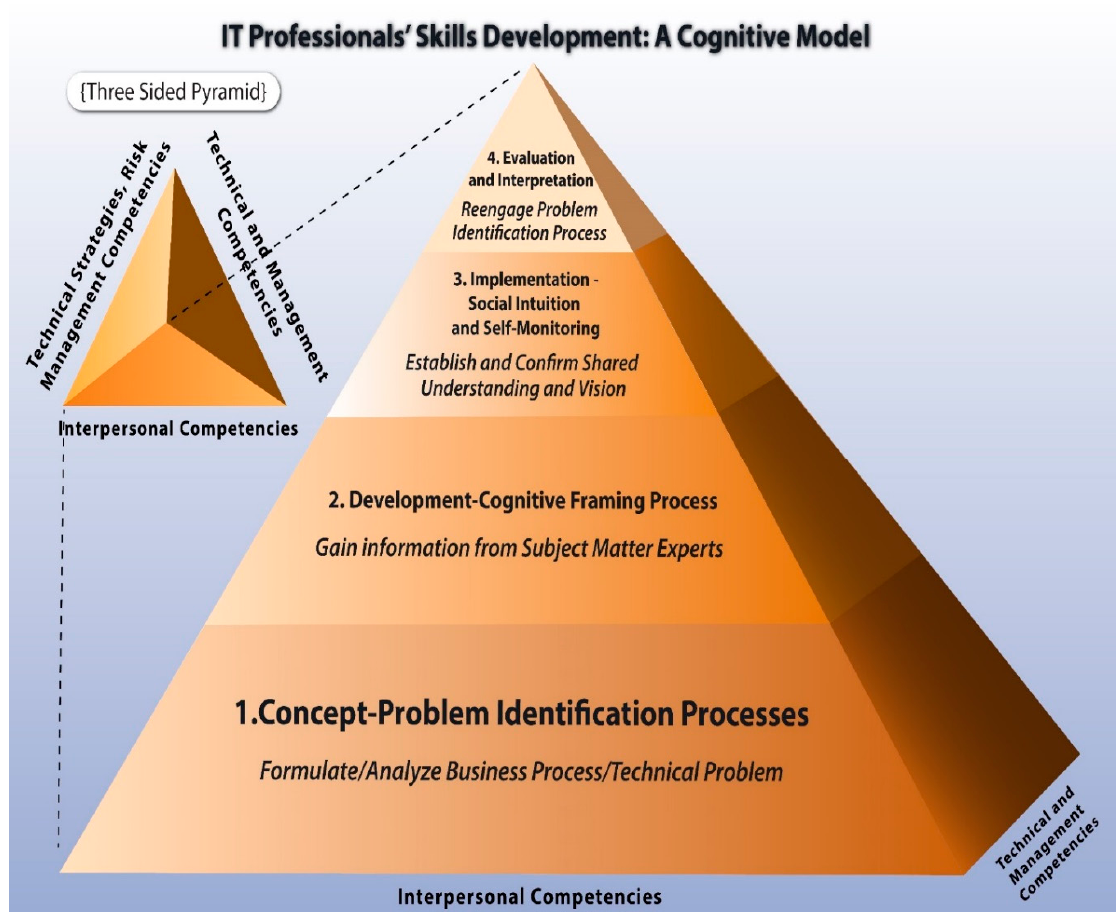
Figure 1. Systems Development Life Cycle Project Framework with Algorithmic Cognitive-Social